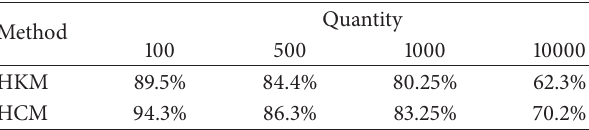
Table 2: Comprehensive comparison of new and traditional mech-